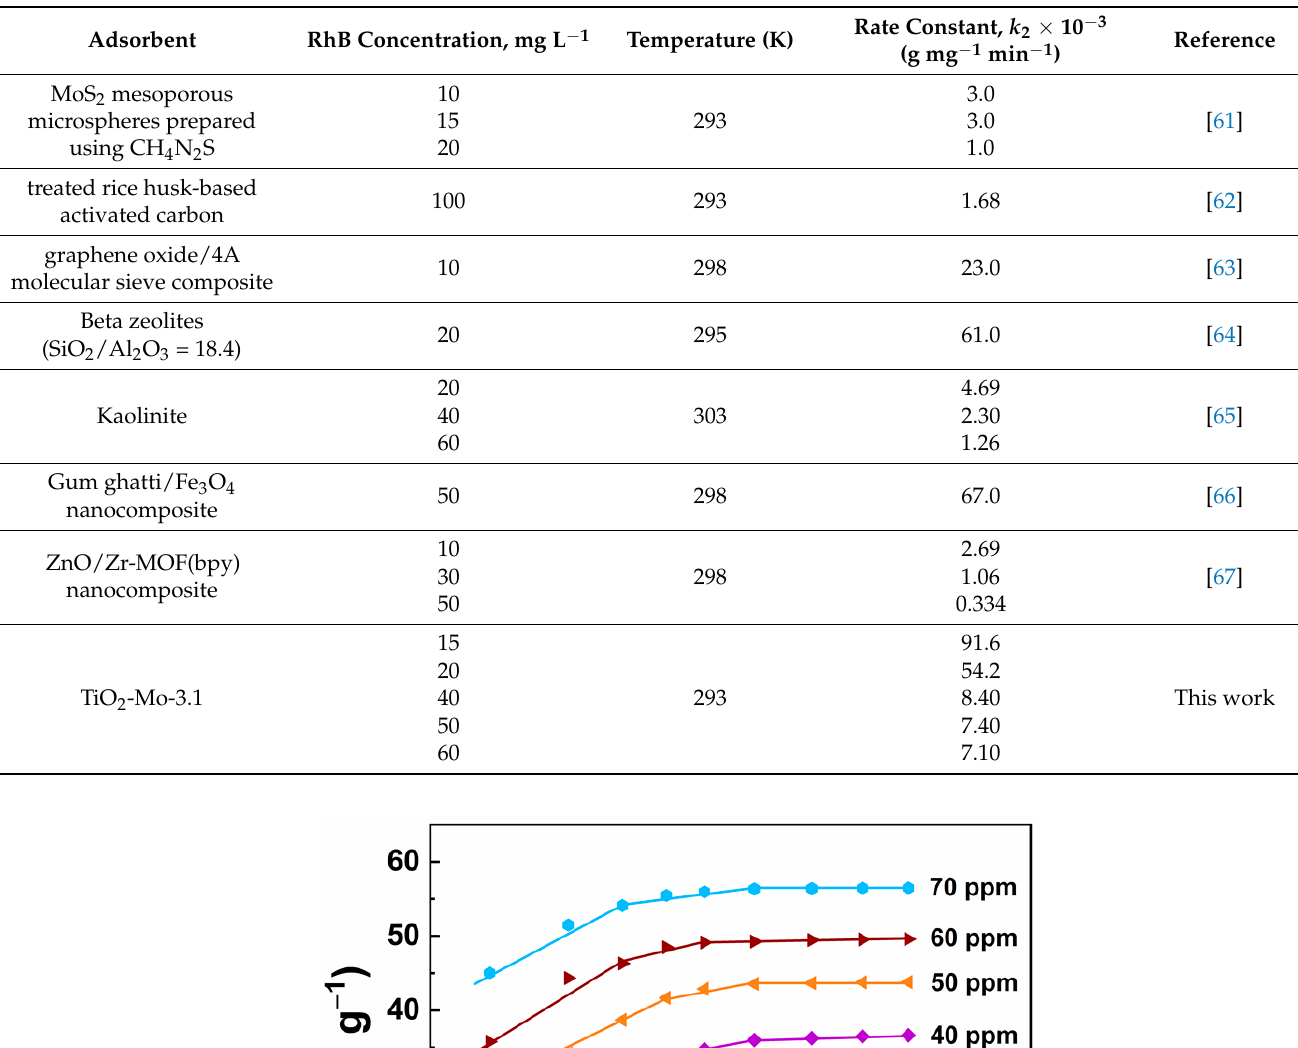
Table 5. Previously reported pseudo-second order rate constants for RhB onto other adsorbents.